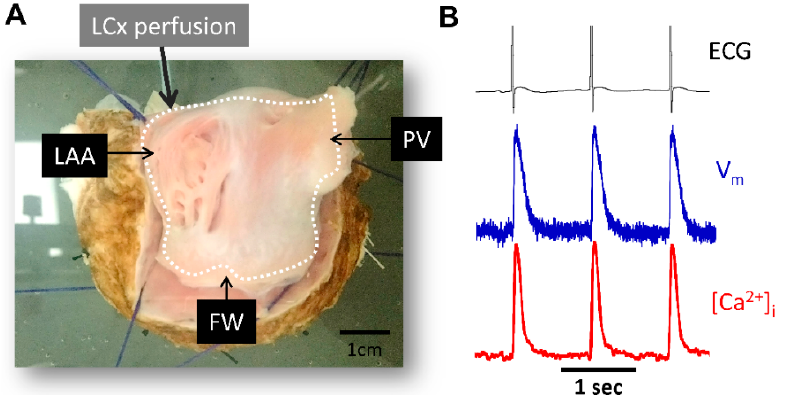
Figure 1. Experimental set-up for dual optical mapping of V m and [Ca 2+ ] i . ( A ) Picture and ( B ) schematic diagram of the optical design.